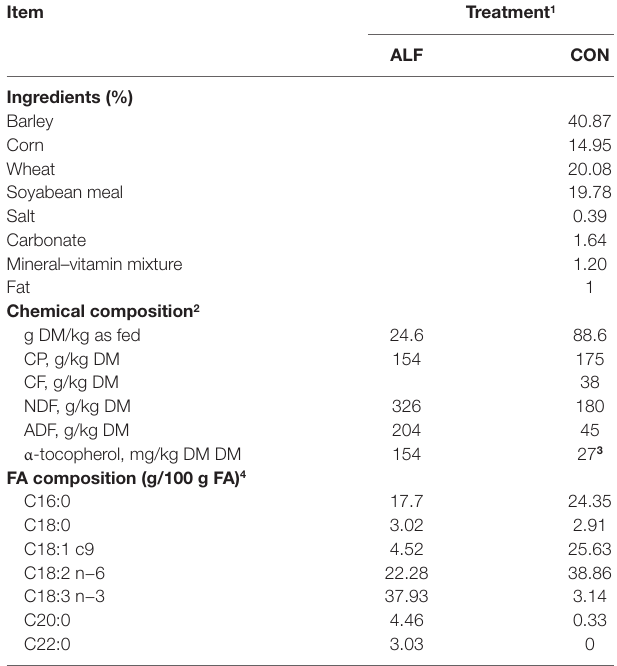
TABLE 1 | Ingredients and chemical composition of the feedstuffs used in the experiment.